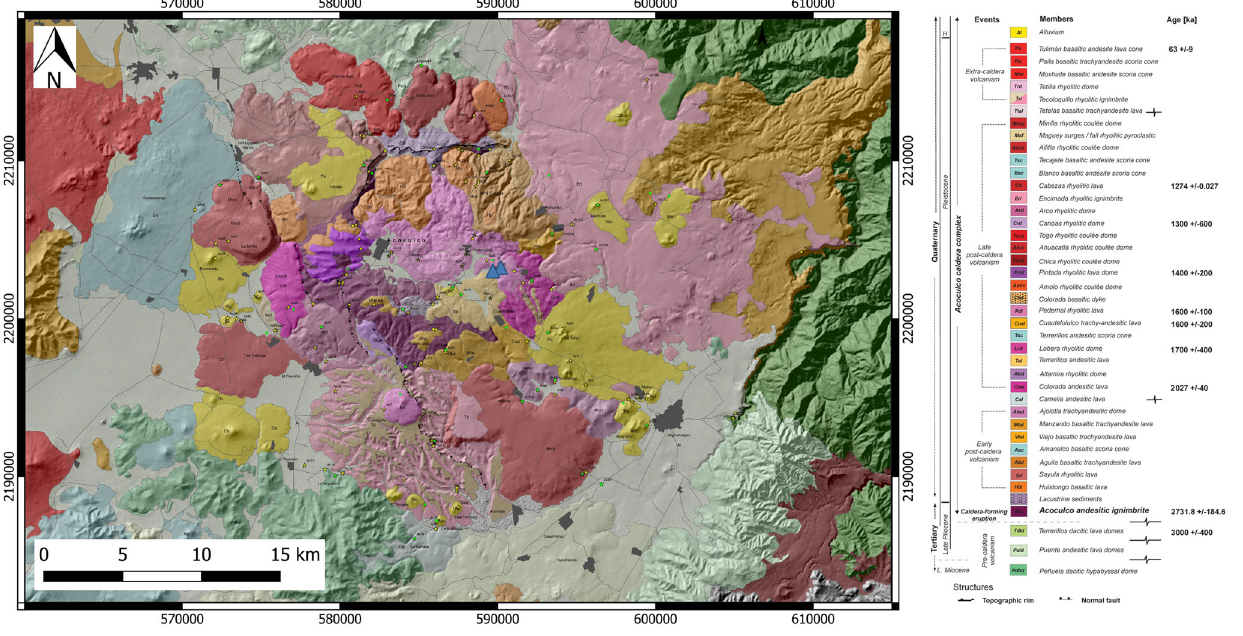
Figure 4. Geological map of Acoculco adapted from Avellán et al. (2018a). Blue triangles: location of the two wells used for modelling. Coordinate system is WGS84/UTM zone